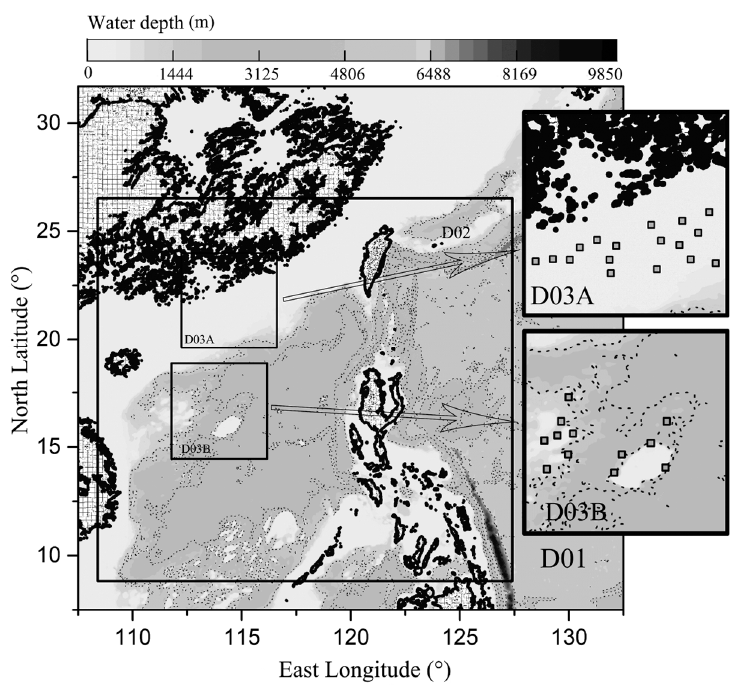
Figure 1. The weather research and forecast (WRF) domain configuration shown on top of the hydrology map of the South China Sea. 29 potential floating wind farm sites were indicated by small squares.